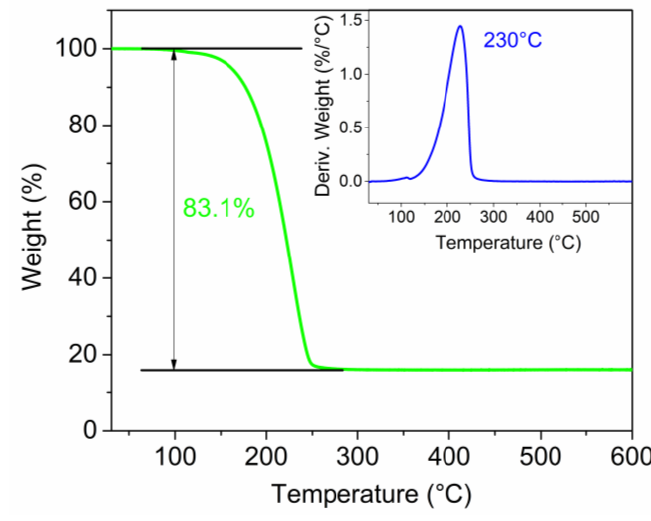
Figure 3. TGA of the composite active material S80SWCNH20.